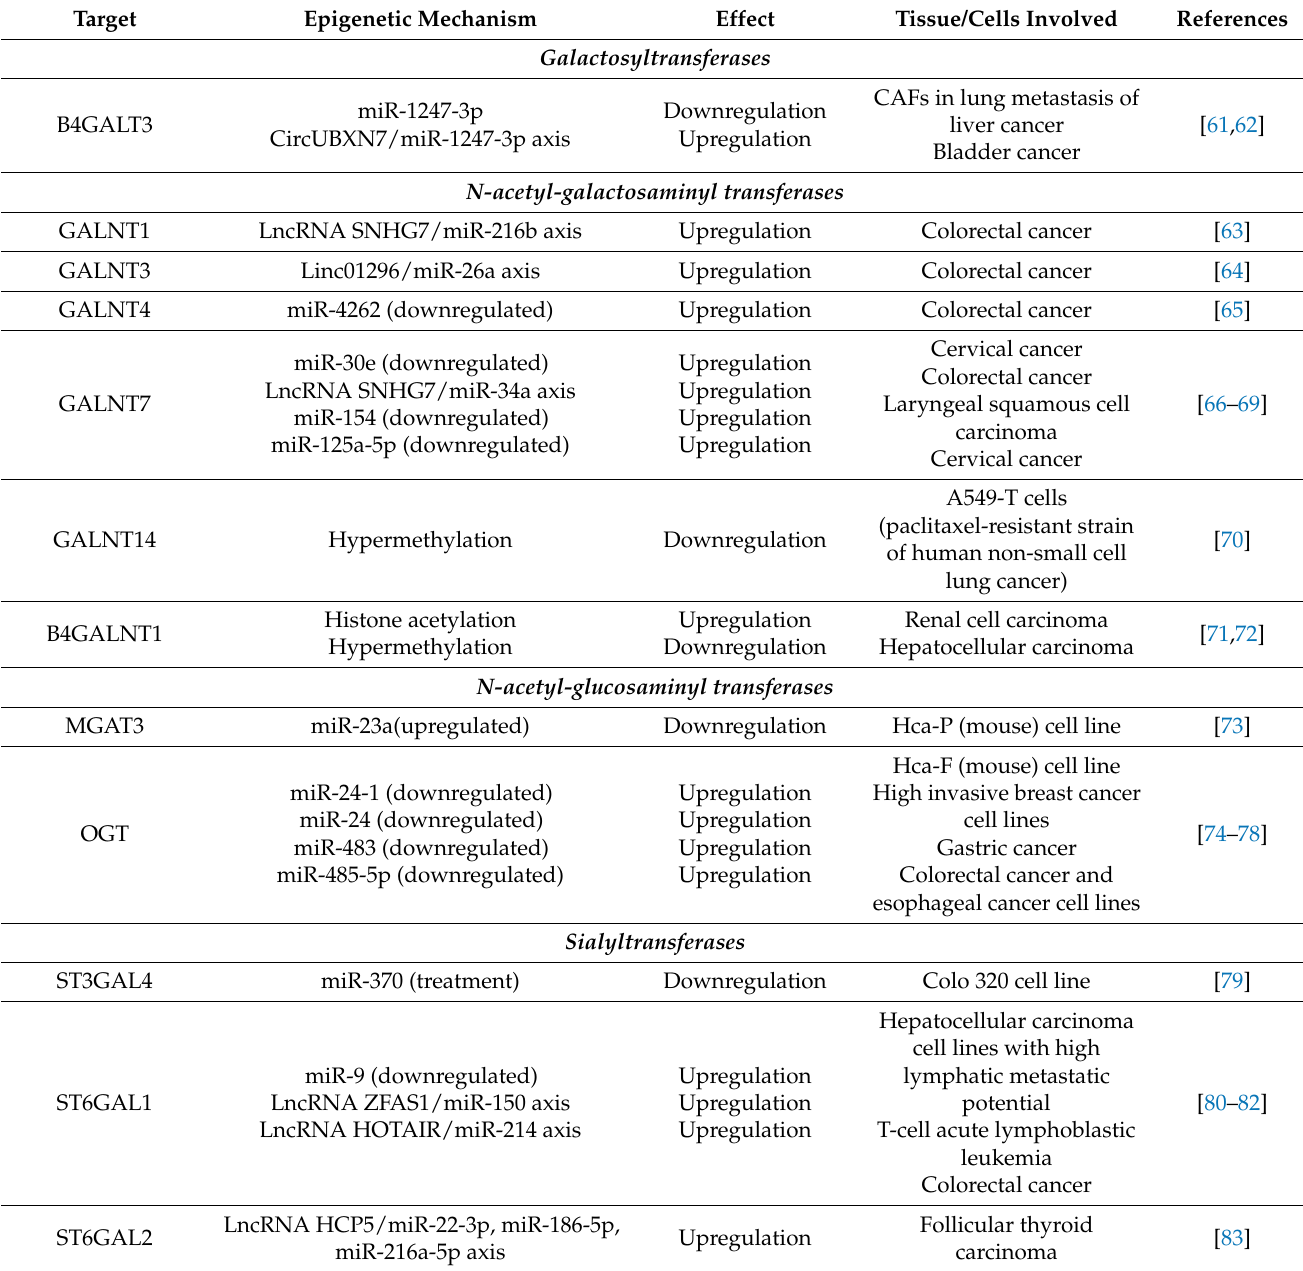
Table 1. List of glycogenes regulated through